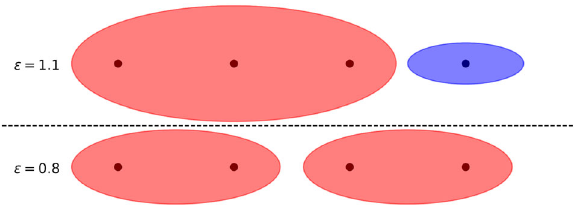
Fig. 5 Clusters of DenStream instances with higher ε values can split into clusters with a higher point coverage due to processing order and the micro-cluster architecture